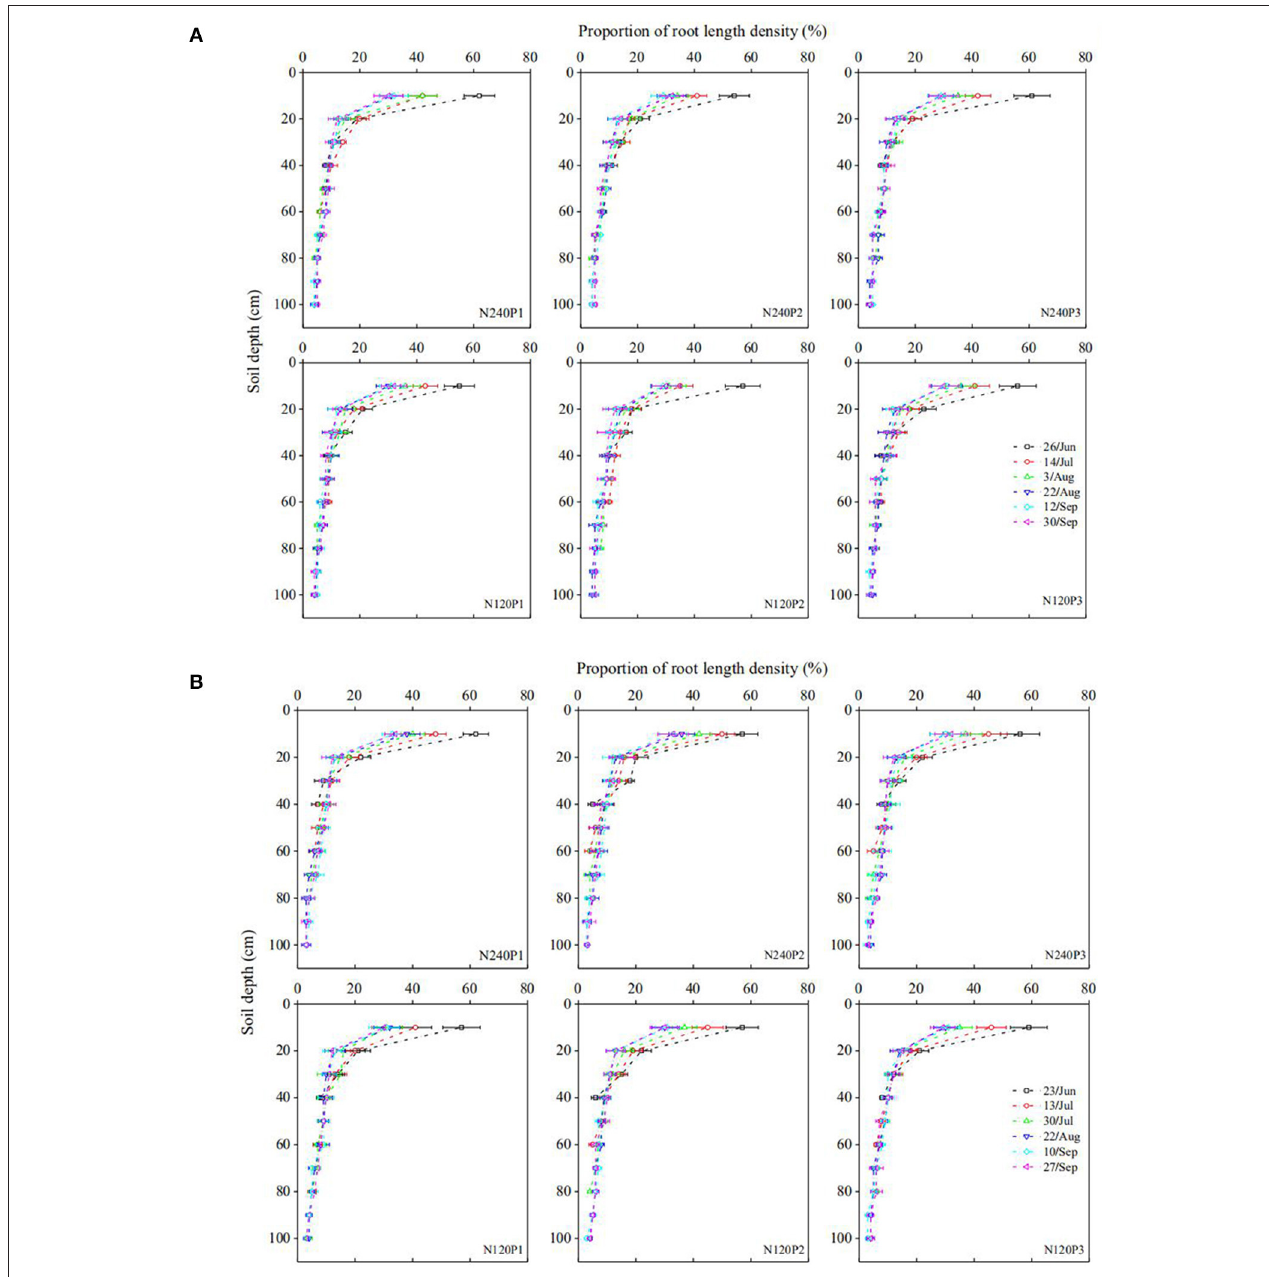
FIGURE 5 | Spatiotemporal variation in the normalized root density under different treatments (see Figure 1A ) in 2016 (A) , and 2017 (B)